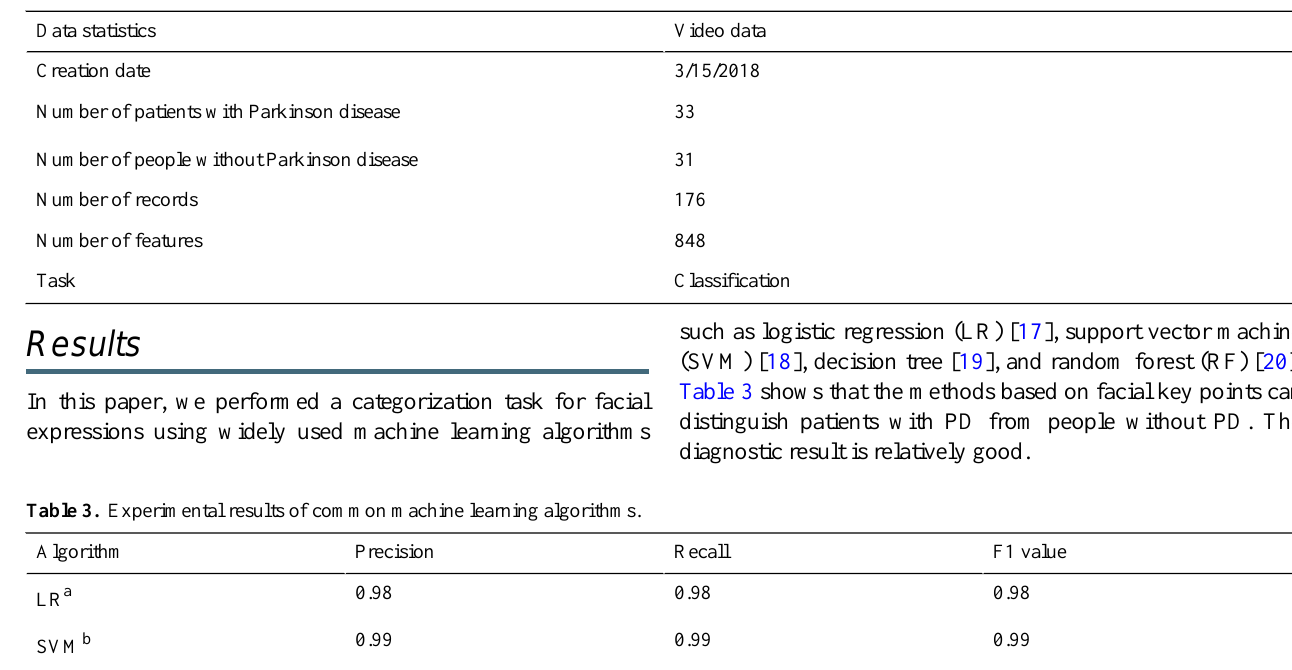
Table 2. Video data statistics.